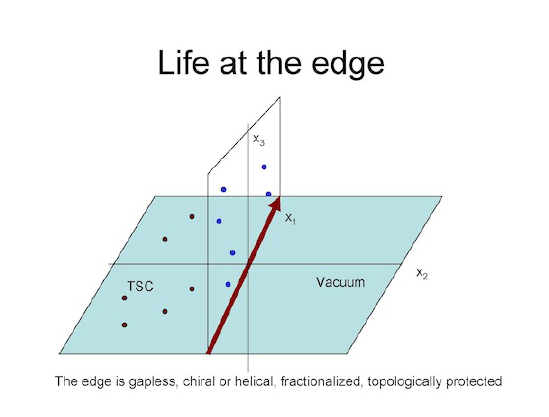
Fig. 1. The d = 2 bulk with a d = 1 edge in the horizontal plane. The vertical plane perpendicular to the edge is its Eu- clidean spacetime. The dots in both planes denote the arguments of the wavefunction or correlation